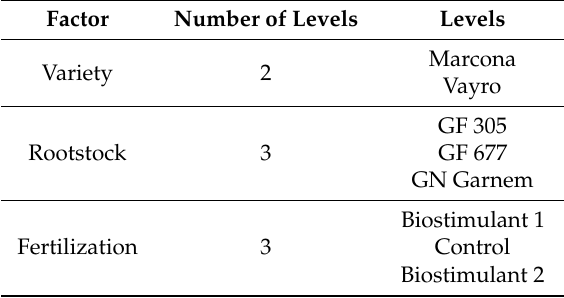
Table 1. Factors and levels analyzed for the characterization of almond trees